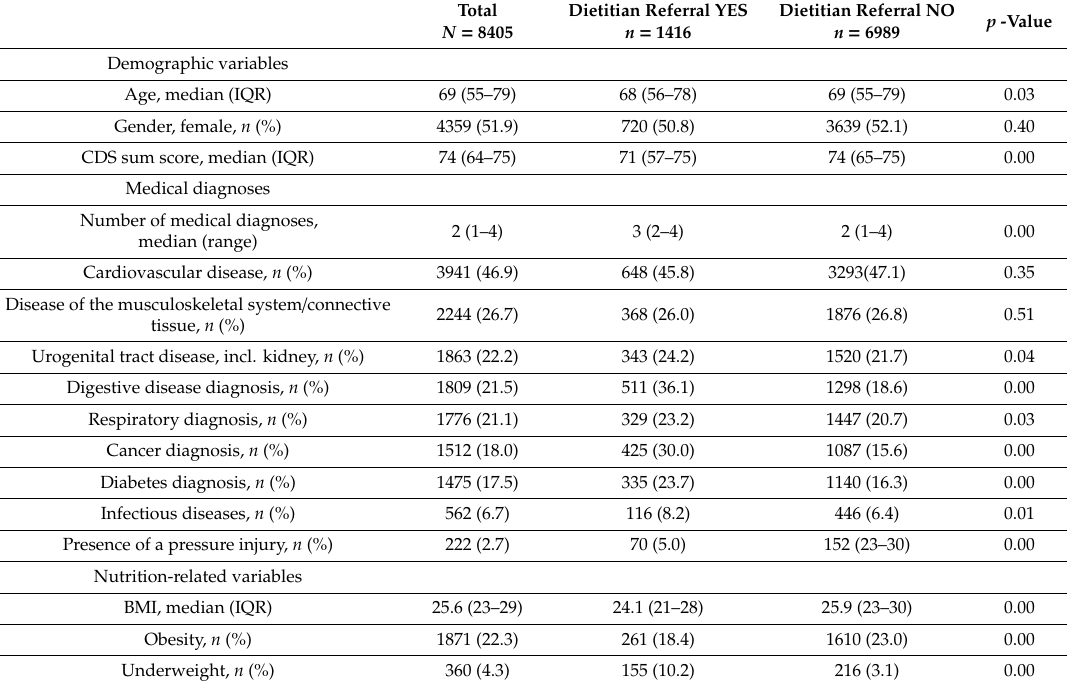
Table 1. Patient characteristics for all patients, as well as for patients with and without a dietitian referral.